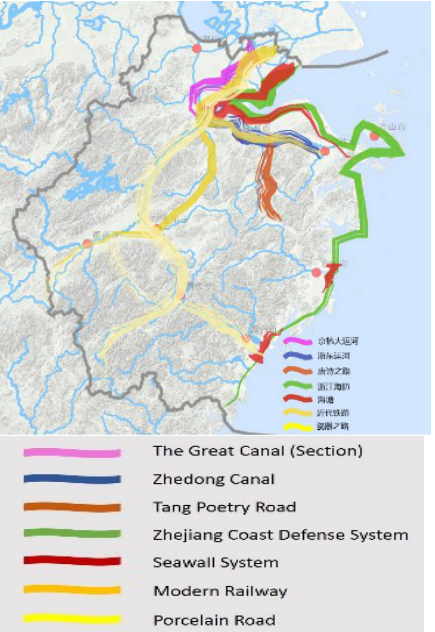
Figure 7. The Distribution of Lineal Cultural Heritages in Zhejiang